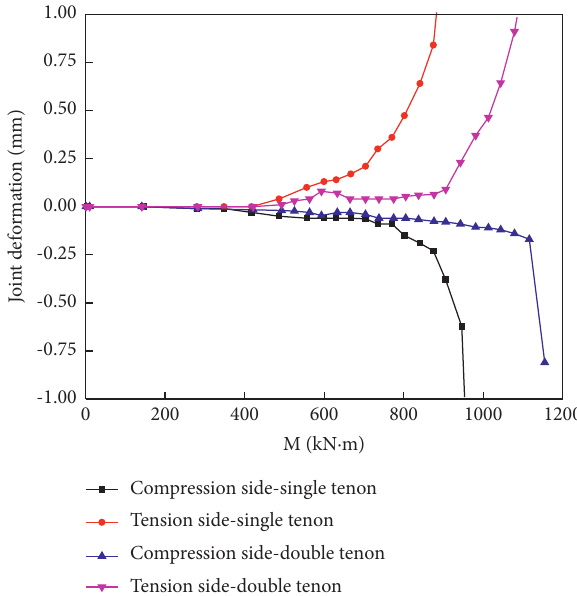
Figure 17: Comparison of joint deformation for single-tenon and double-tenon joints (local zoom).